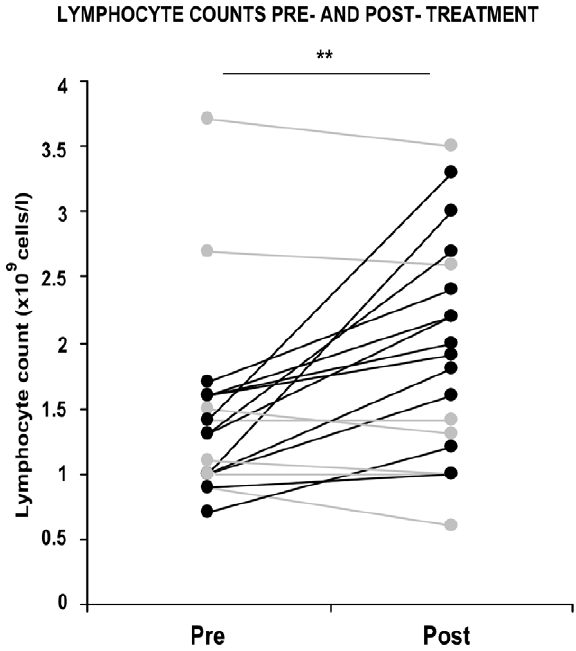
Figure 1. Patient lymphocyte counts pre- and post antituber- cular chemotherapy. Lymphocyte counts were taken, before and after treatment, from twenty patients who were culture-positive for Mtb. Each joined pair of data points represents pre- and post-therapy lymphocyte counts ( 6 10 9 cells/l) from a single patient. Data from patients whose lymphocyte counts recovered following treatment are shown in black; counts from patients whose lymphocyte counts fell or did not change are shown in grey. **= p , 0.01, paired Student’s t test comparing pre-treatment vs post-treatment counts.